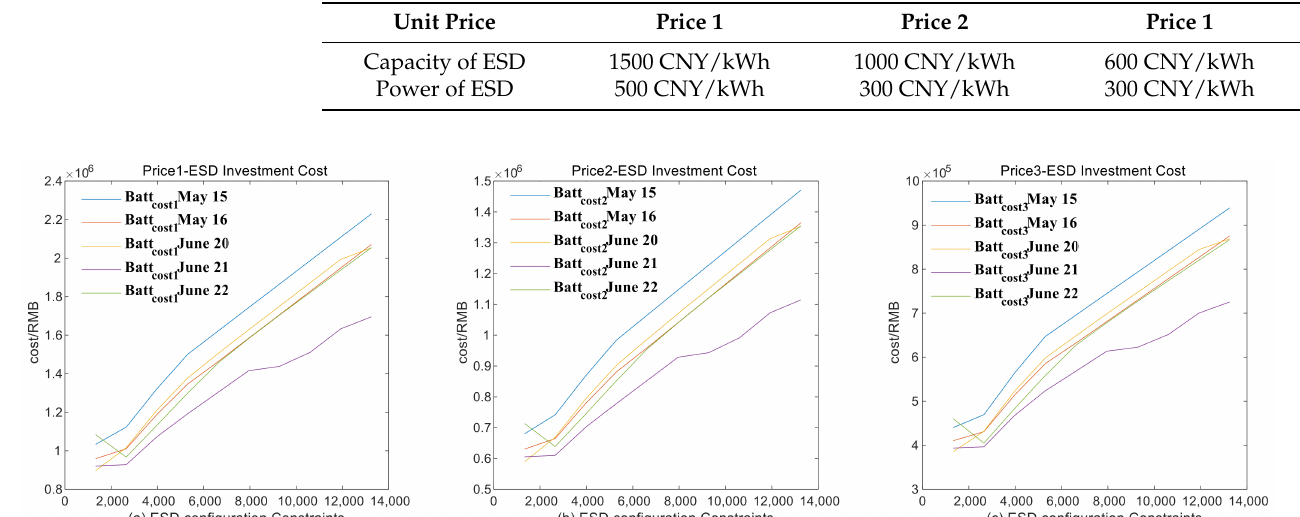
Figure 15. Initial investment cost of ESD with different unit